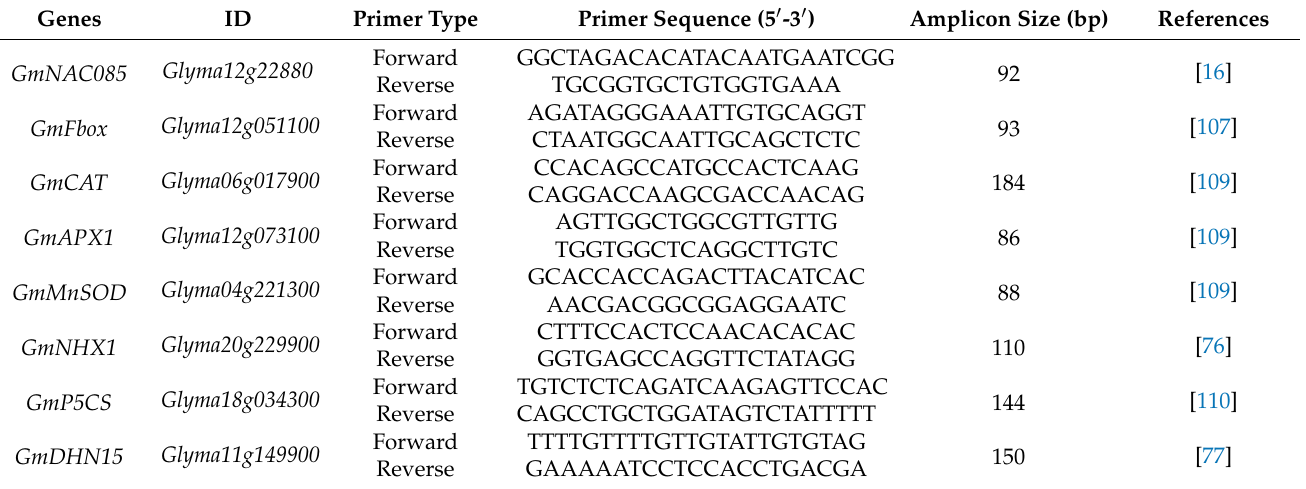
Table 1. Information of primers that were used in gene expression